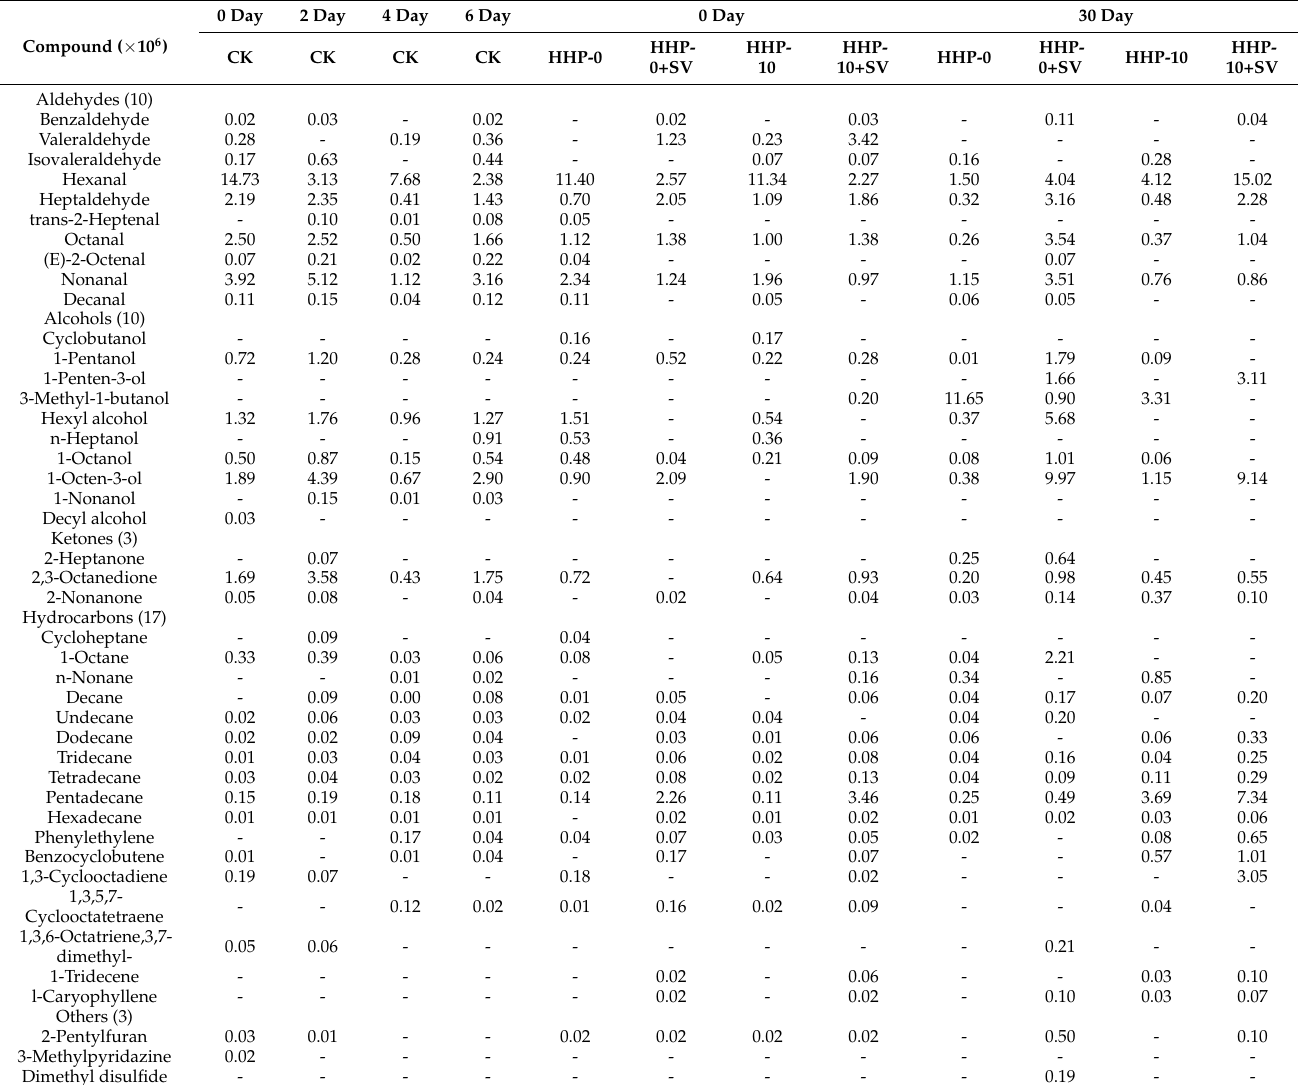
Table 2. Effects of different treatments on the volatile compounds of largemouth bass during